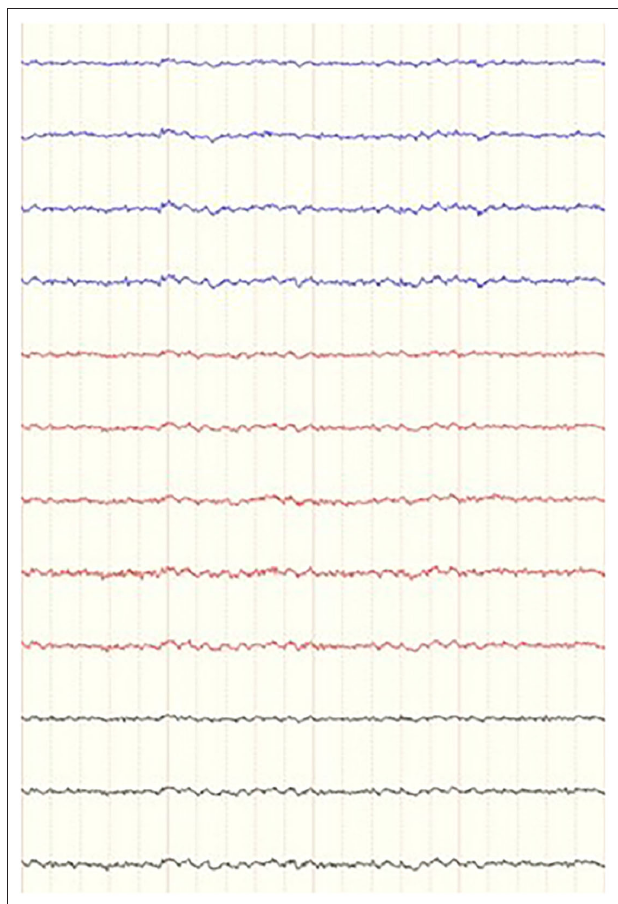
FIGURE 5 | Example of a 4-s epoch of a dog in a during a period of “calm” behavior as it was presented to the blinded investigator. Referential montage, low frequency filter 0.16ms, high frequency filter 70Hz, notch filter 60Hz and sensitivity of 7 uV. Ms, milliseconds; Hz, Hertz.